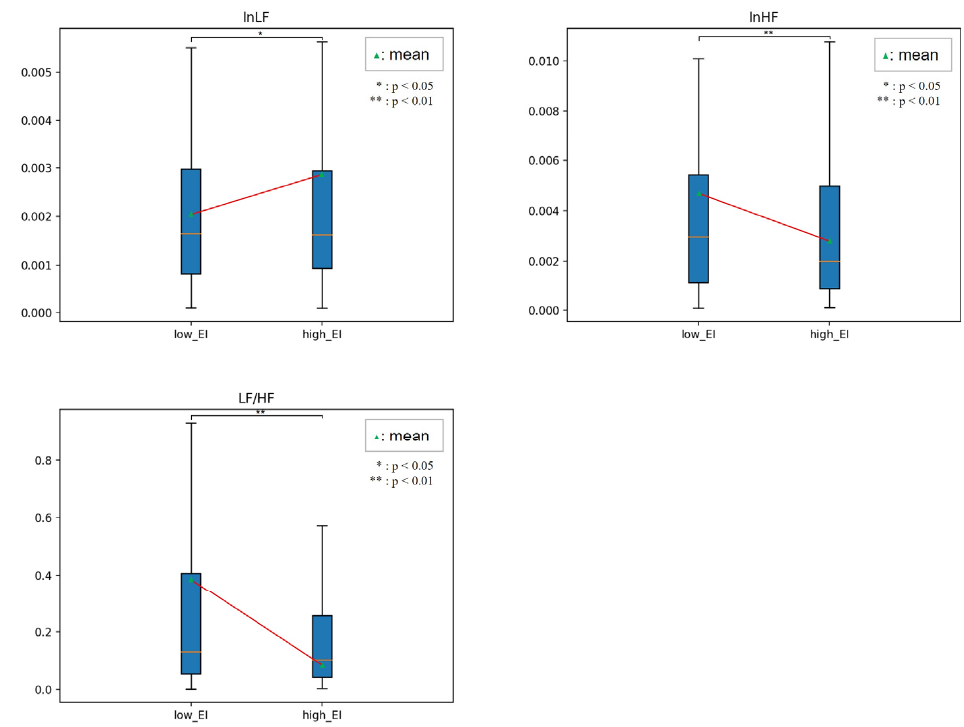
Figure 11. Comparison between low and high EI in variability.